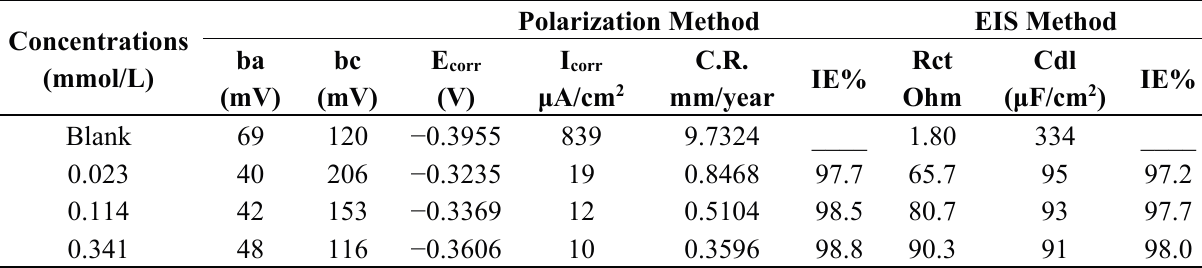
Table 4. Inhibition efficiency values of steel electrode in 1 M HCl containing various concentrations of the ODA-TS calculated by polarization and EIS